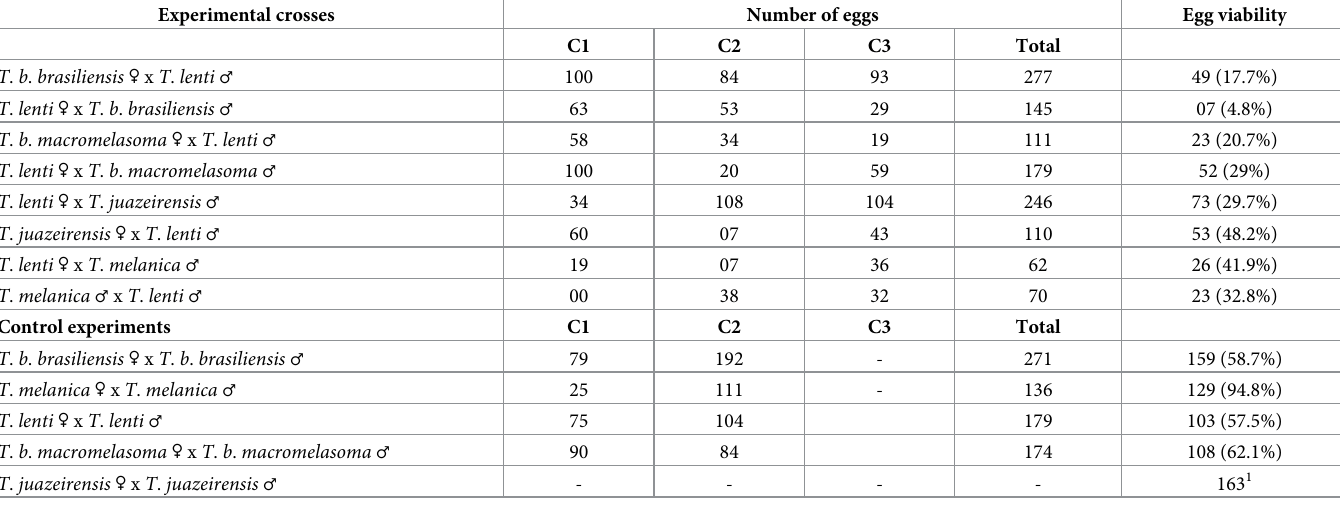
Table 1. Experimental crosses performed between T . b . brasiliensis , T . b . macromelasoma , T . juazeirensis and T . melanica with T . lenti . Experimental